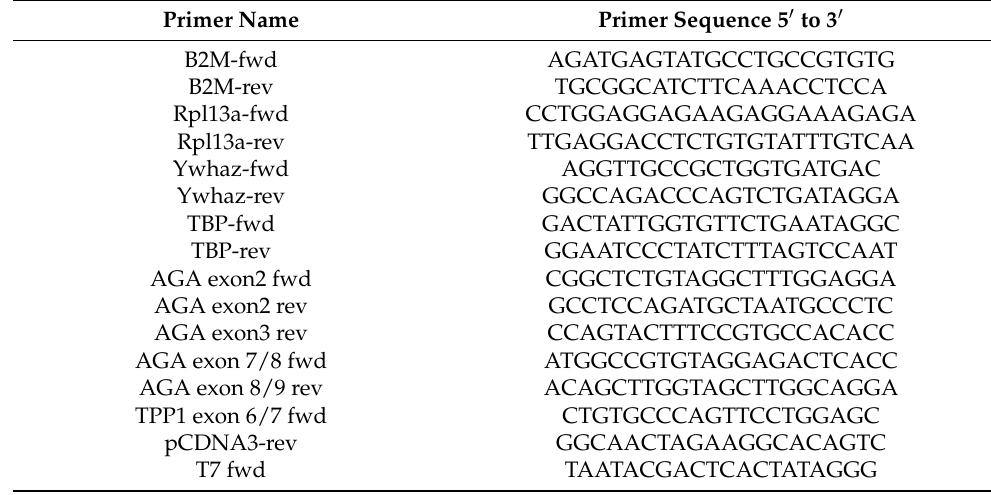
Table 2. Sequences of primers used for the quantitative real-time PCR. All sequences are shown in 5 (cid:48) to 3 (cid:48)